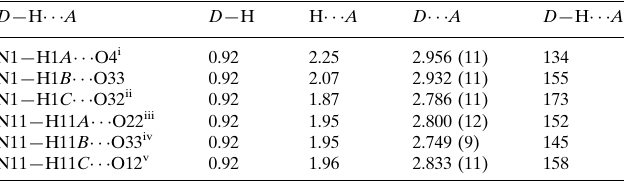
Hydrogen-bond geometry (A˚ , (cid:4)